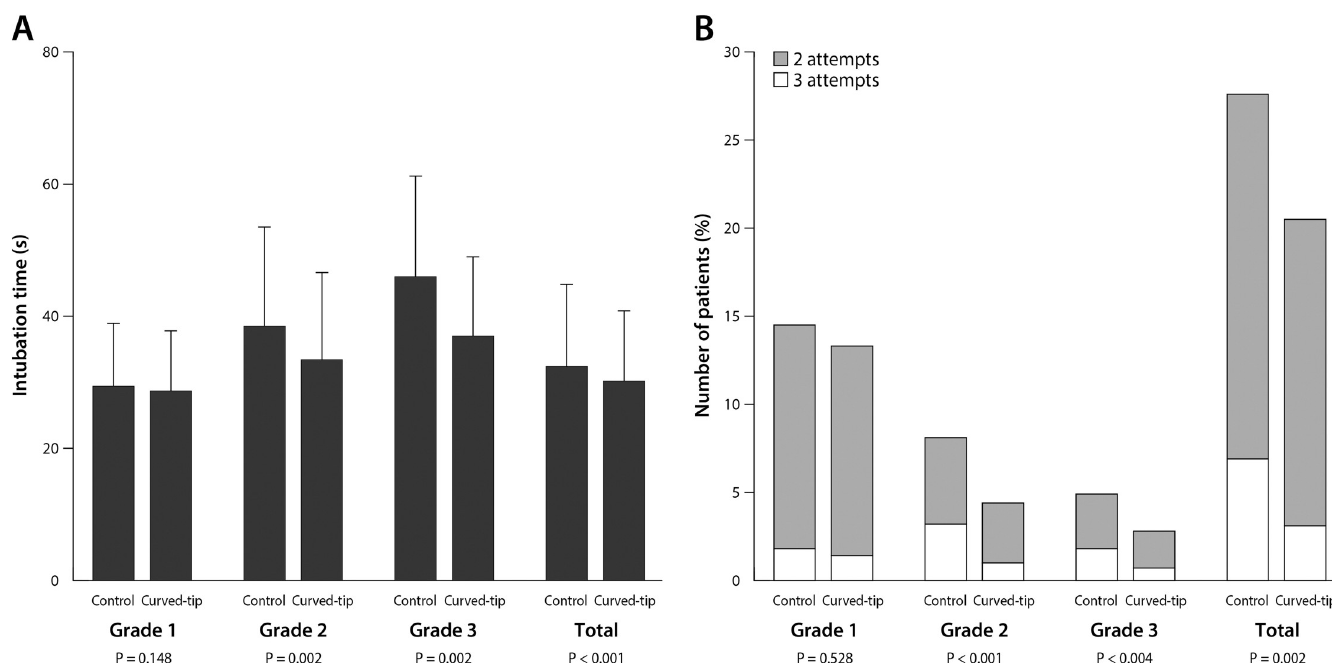
Fig 3. Mean time (A) and number of attempts (B) for intubation of left-sided double-lumen tubes in patients with each grade of laryngoscopic view. Error bars are standard deviations. P values were obtained by comparing the intubation time between groups using unpaired t-tests (A) and by comparing the number of intubation attempts using Fisher’s exact tests